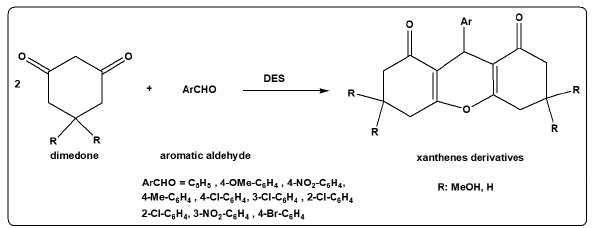
Figure 15: DES catalysed synthesis of xanthenes derivatives. k k See Azizi et al [76] for detailed reaction components and conditions.